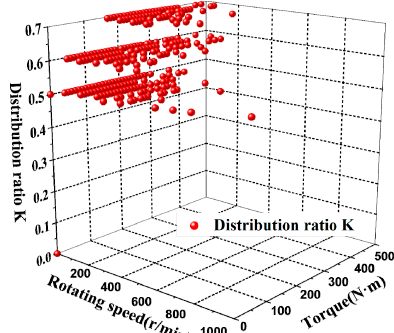
Figure 13. Torque distribution ratio map optimized by dynamic planning algorithm for HUPDC.